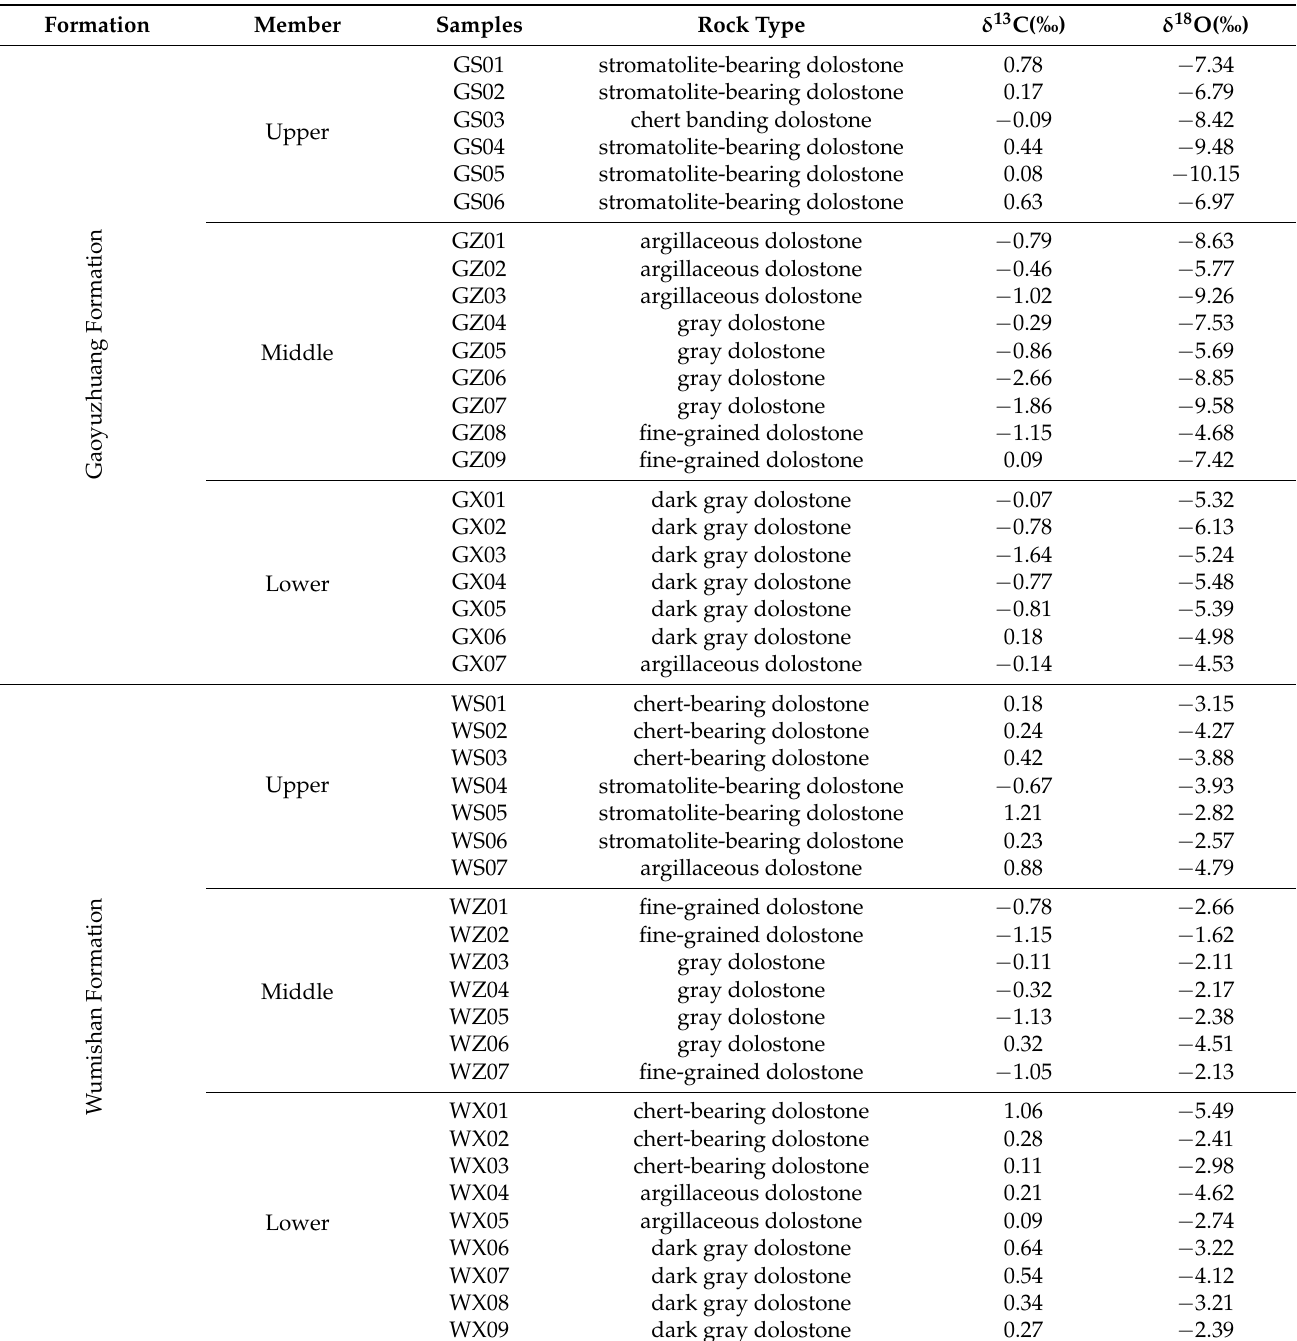
Table 2. Carbon and oxygen isotope compositions of the carbonate rocks in the Gaoyuzhuang and Wumimshan